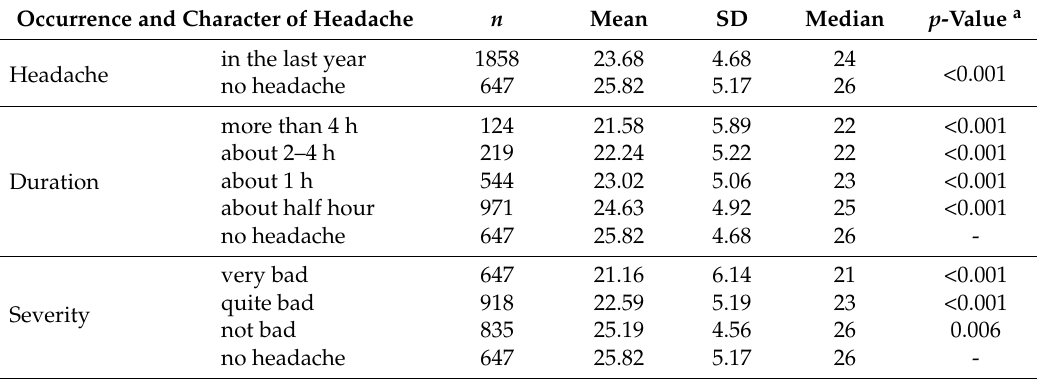
Table 5. Discriminant validity of the HRQoL